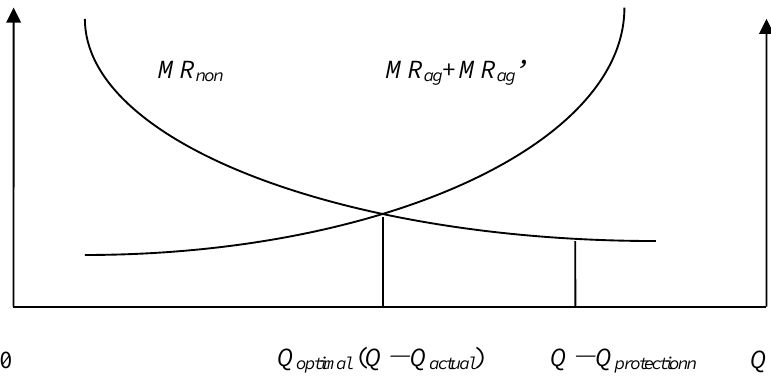
Figure 1. Allocation of county-level land resources under the first situation.